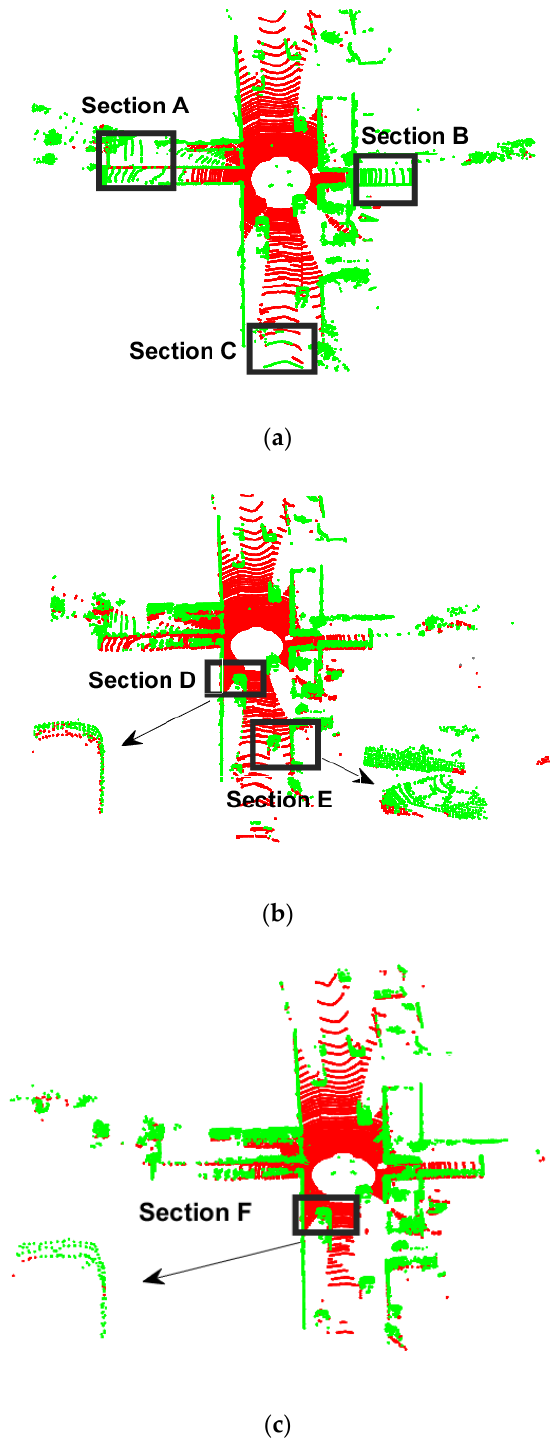
Figure 9. Algorithm segmentation effect comparison in KITTI dataset 2011_09_26_drive_0051 . ( a ) RANSAC algorithm. ( b ) RGF algorithm. ( c ) Proposed algorithm.